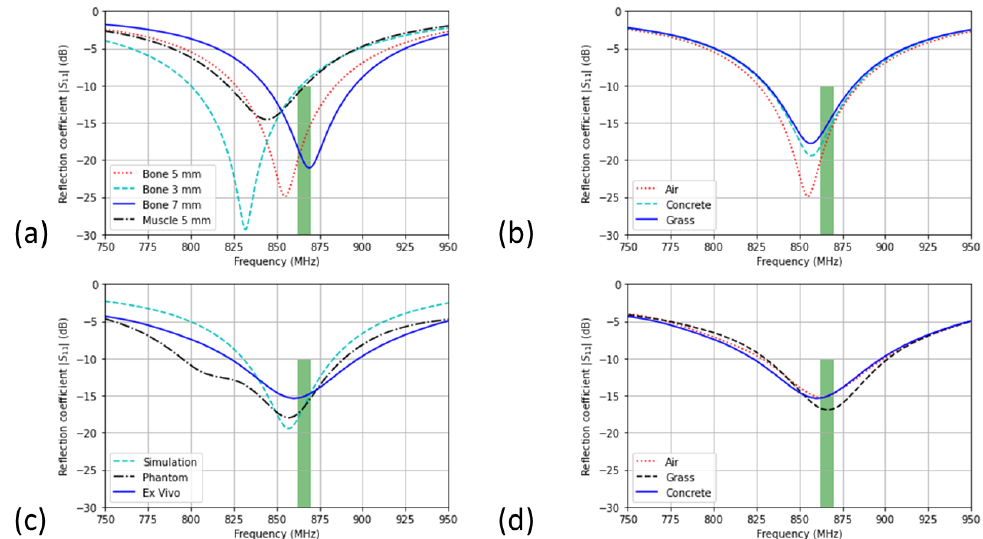
Figure 4. ( a ) Simulated reflection coefficient | S 11 | for the antenna in air. To characterize the impedance robustness, the phantom is modelled as muscle or bone, and the epoxy layer is varied from 3 mm to 7 mm; ( b ) robustness of the hoof-antenna against the different soil types (simulated); ( c ) measured reflection coefficient using a phantom leg and an ex vivo leg; ( d ) measured reflection coefficient with the leg standing on different soil